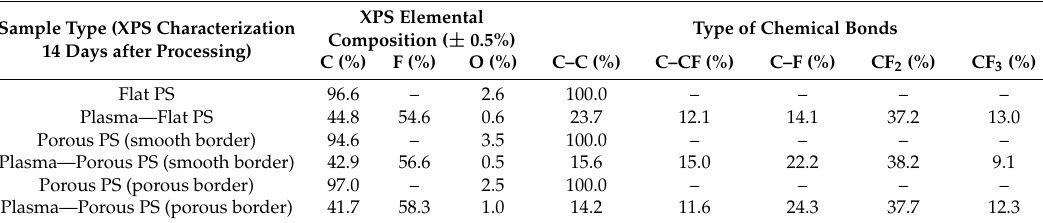
Table 2. XPS characterization of plasma-untreated and treated PS substrates 14 days from processing. The smooth borders were prepared by five doses of 1.5 THF:8.5 ETH at 295 K. Porous borders were prepared with five doses of 2.5 THF:7.5 ETH at 303 K. The power of the plasma reactor was 300 W.